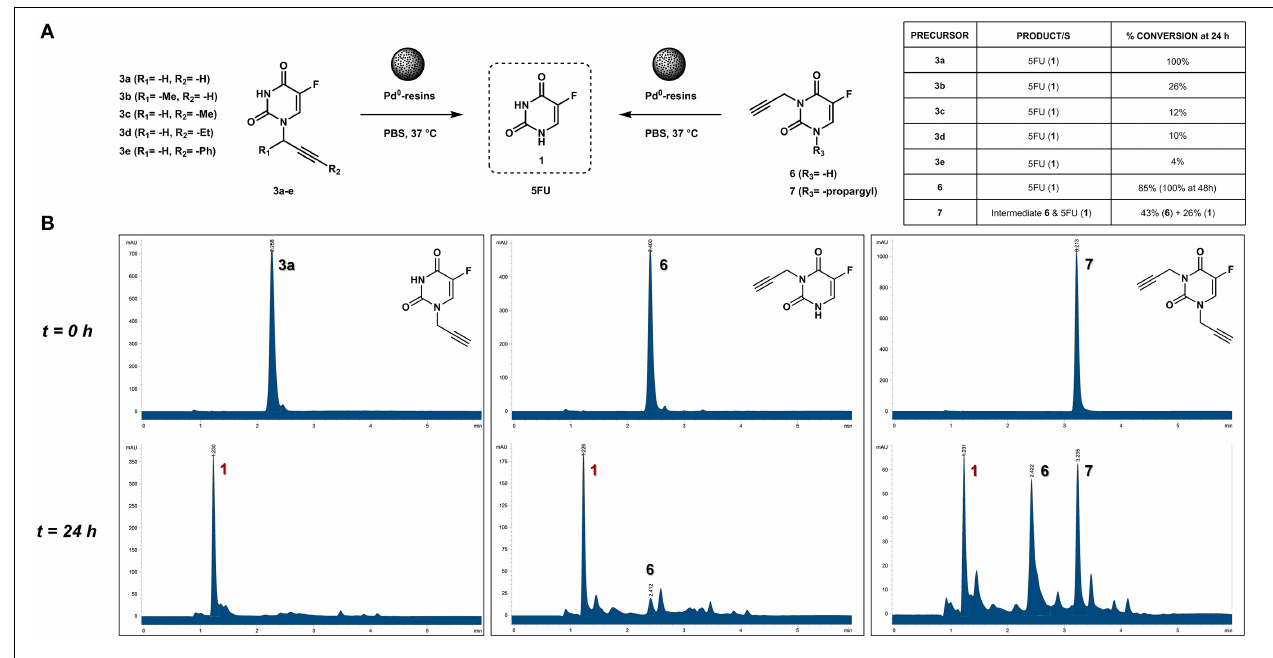
FIGURE 3 | (A) Palladium-mediated dealkylation of compounds 3a-e , 6 , and 7 and table containing conversion percentages (relative values calculated by chromatographic peak integration). Each of the drug precursors (100 μ M) were incubated with 1mg/mL of Pd 0 -resins in PBS at 37 ◦ C for 24h and the